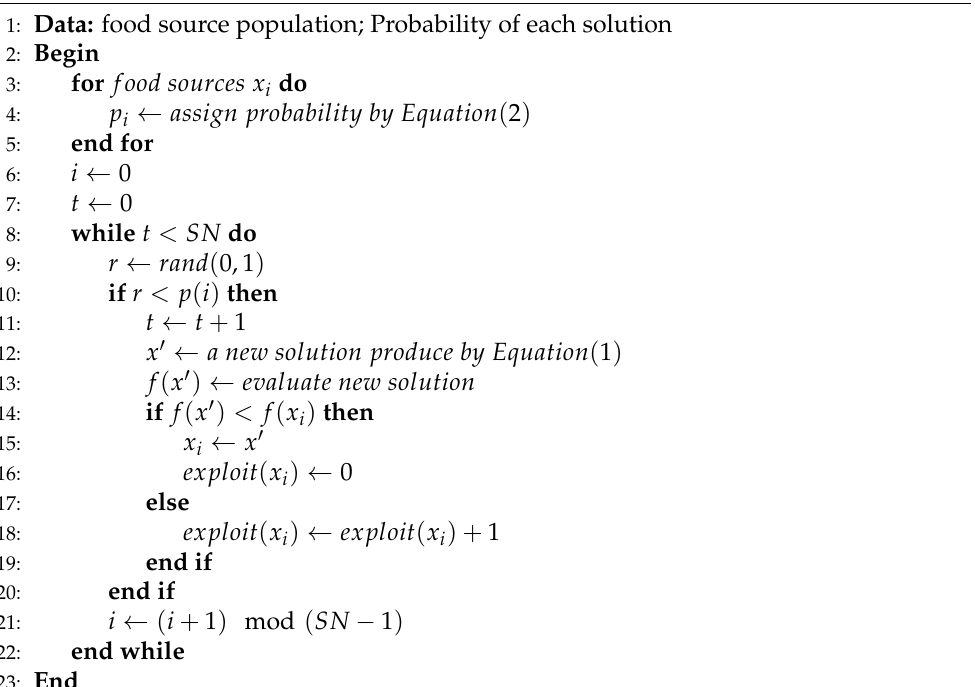
Algorithm 3 Onlooker Bees’ Labor Pseudocode (Modified from [15]).